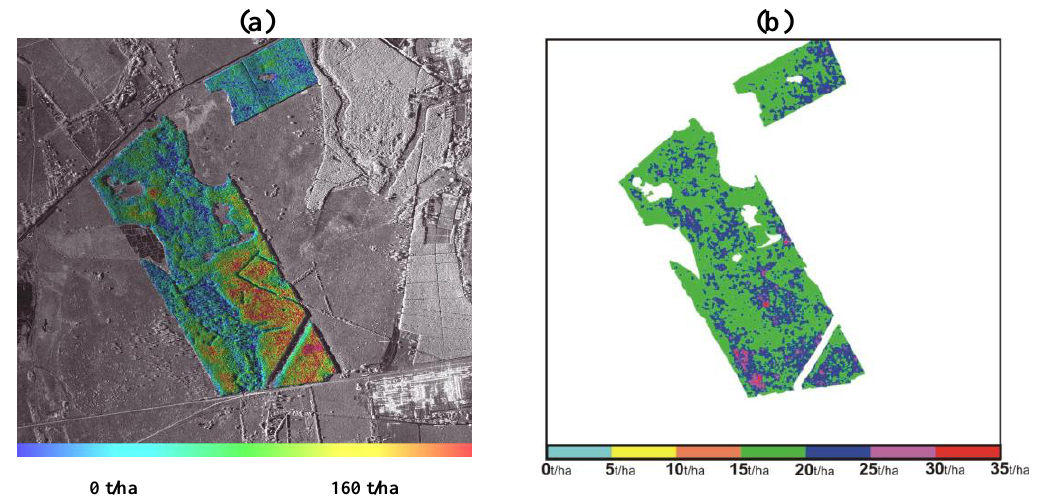
Figure 14 . (a) IHS image from biomass model (I = X-band image, H = vegetation biomass, S = vegetation mask); (b) Standard deviation image related to biomass